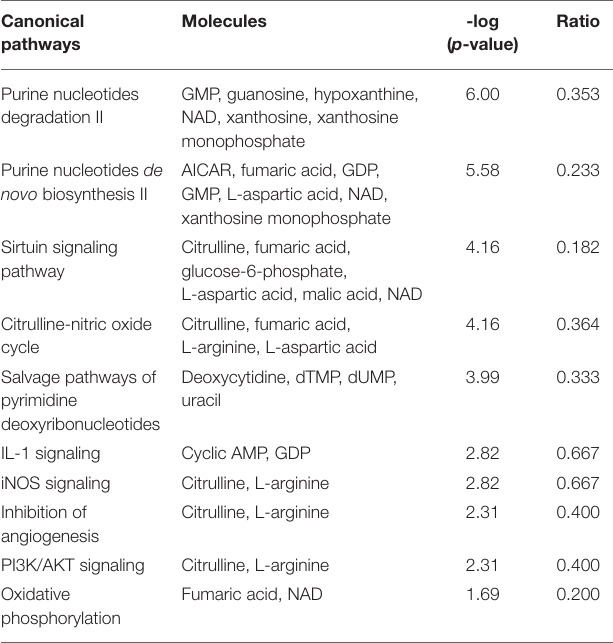
TABLE 3 | Top canonical pathways enriched by observed metabolite alteration in WB myopathy. Canonical pathways